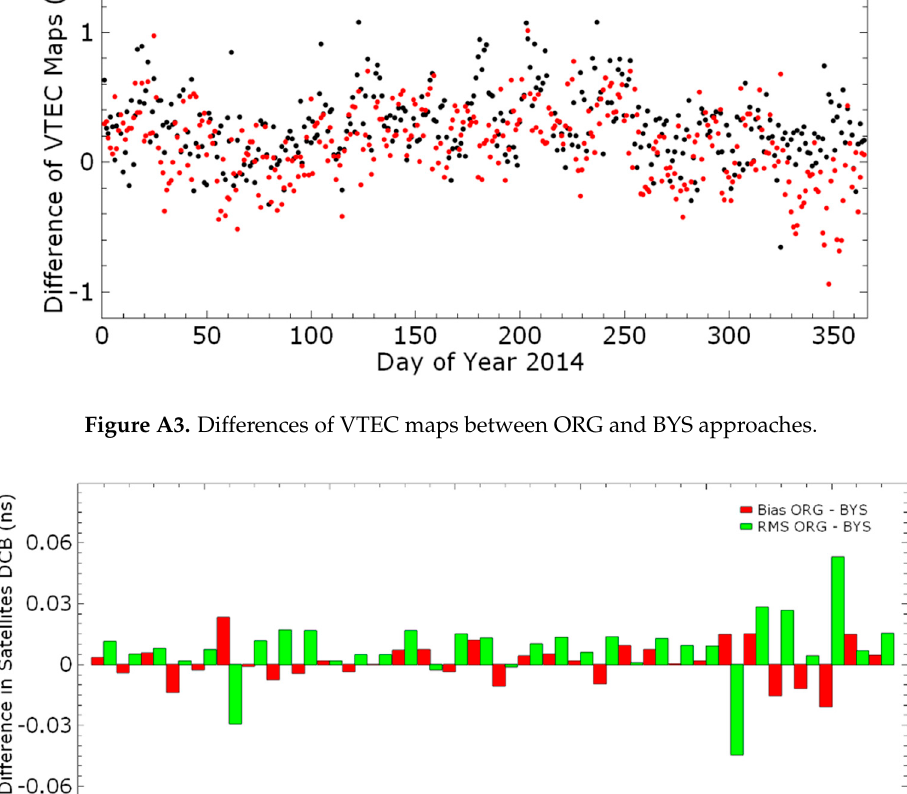
Figure A4. Differences in satellite DCBs between ORG and BYS approaches.